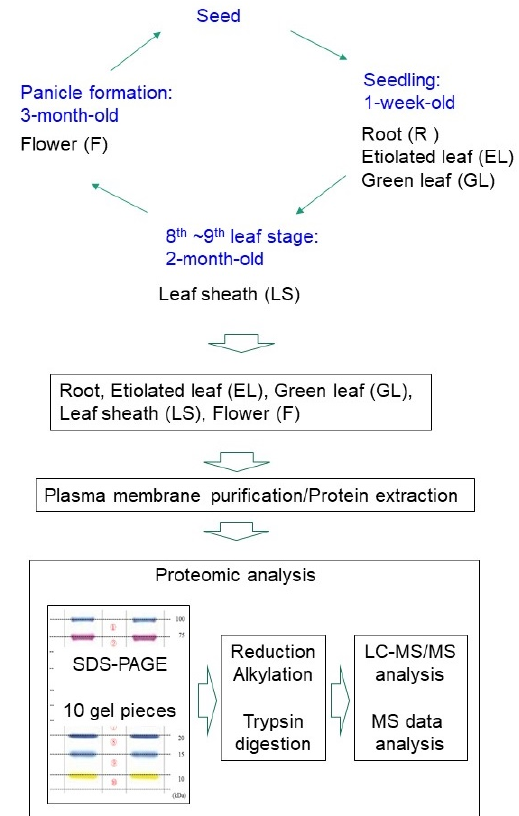
Figure 1. Experimental setup used in this study. Root (R), etiolated leaf (EL), green leaf (GL), leaf sheath (LS), and flower (F) were collected from growing rice plants. Plasma membranes were purified and proteins were extracted from each sample. The extracted proteins were separated by SDS-PAGE and subjected to label-free proteomics analysis.